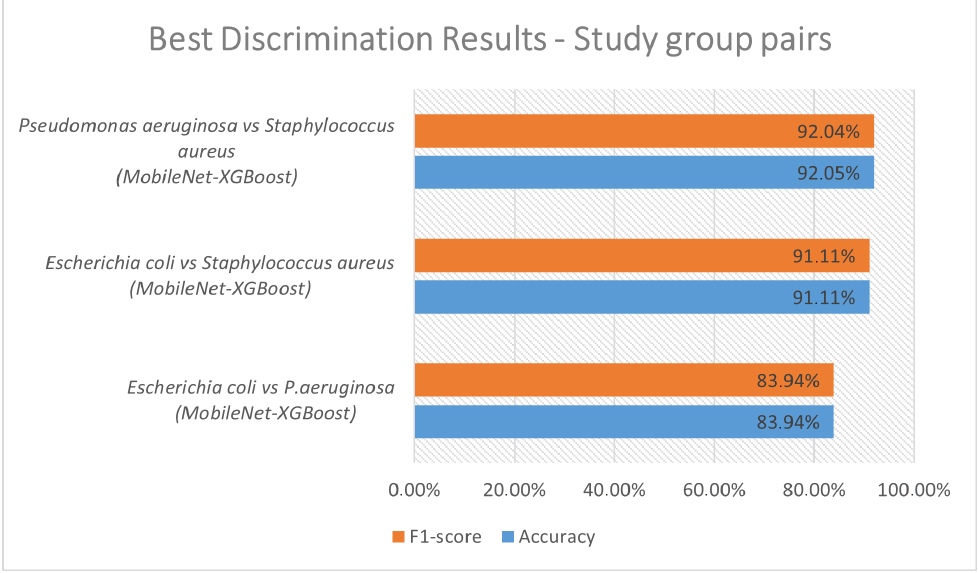
Figure 2. Best discrimination results between study group